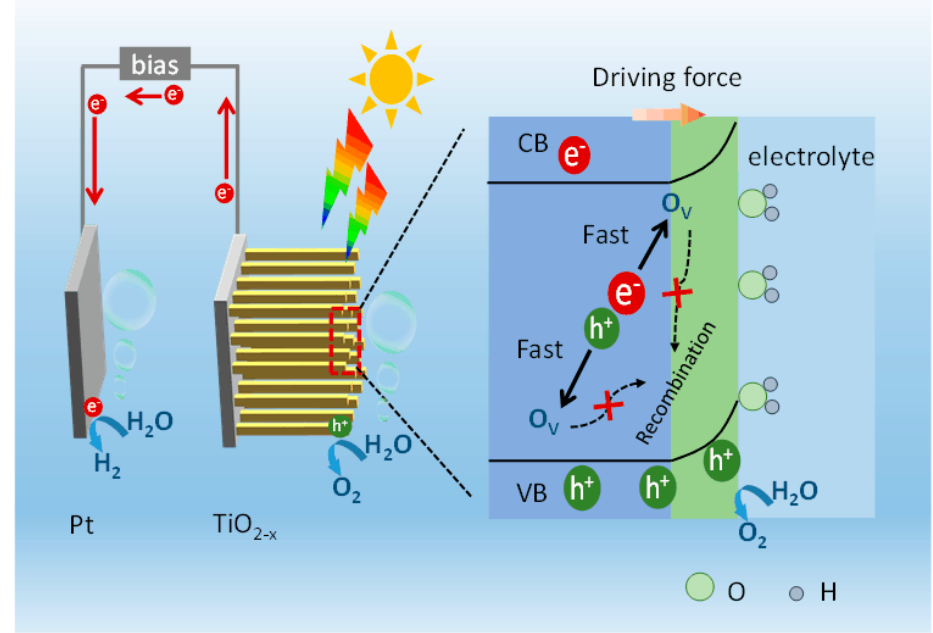
Figure 6. Schematic representation of PEC water oxidation mechanism on TiO 2-x photoelectrode.